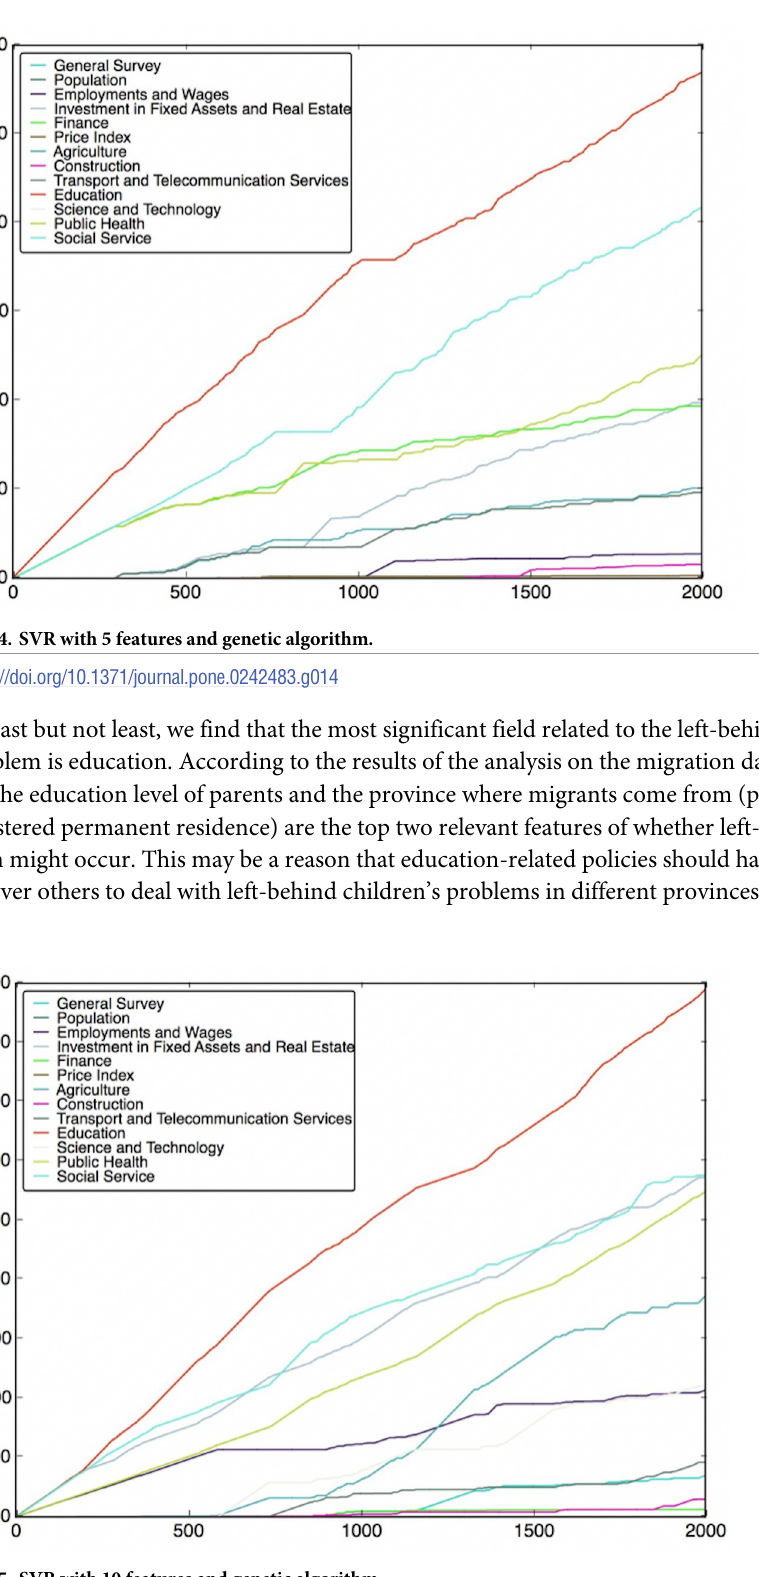
Fig 15. SVR with 10 features and genetic